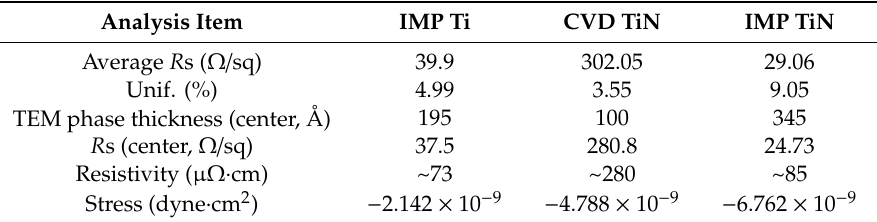
Table 1. Sheet resistance ( R s) and specific resistance value ( ρ ) for each